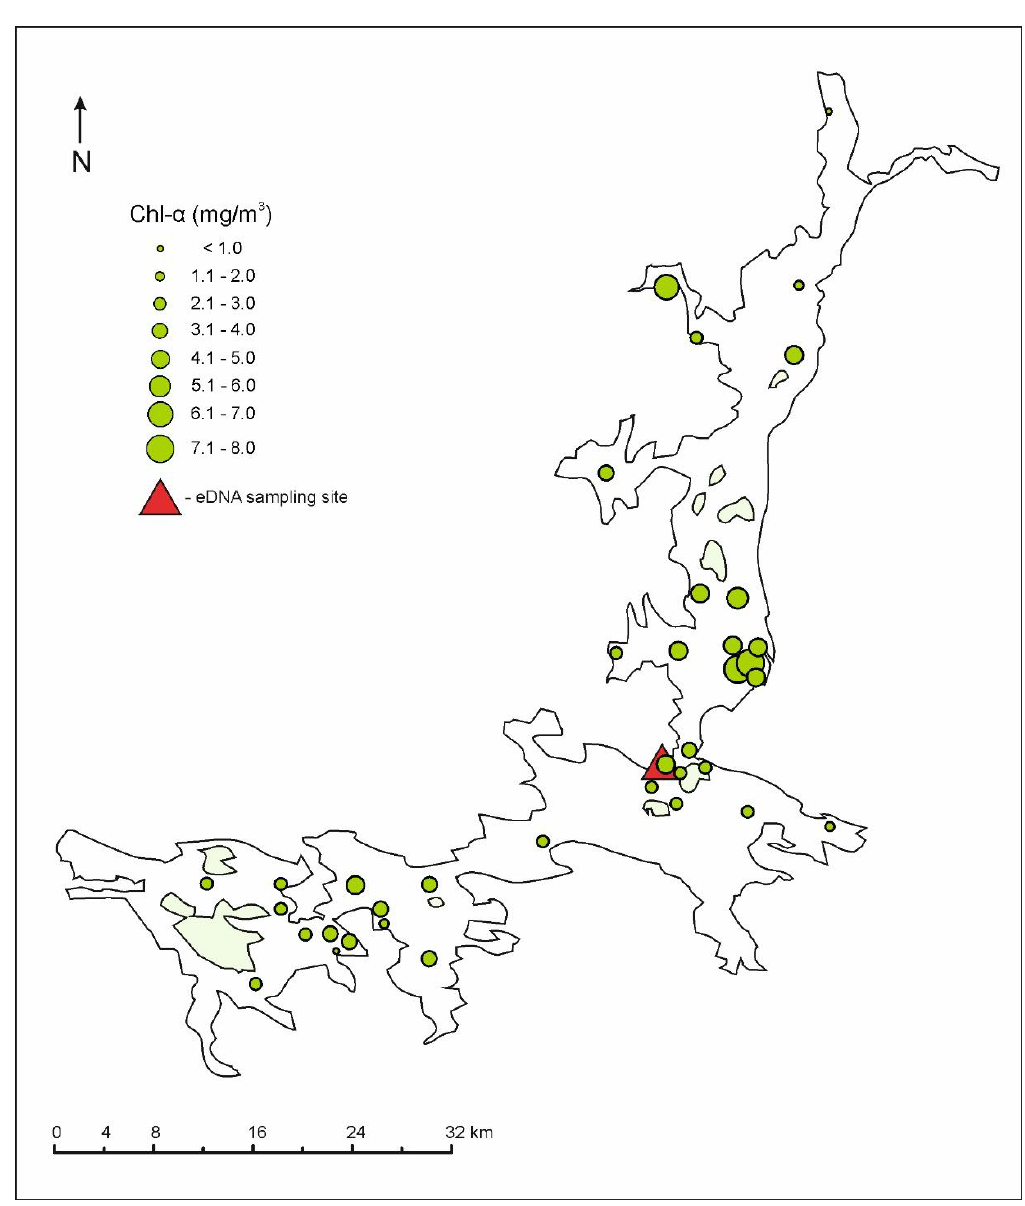
Figure 4. Typical summer distribution patterns of Chlorophyll — a concentrations over different parts of Lake Imandra.